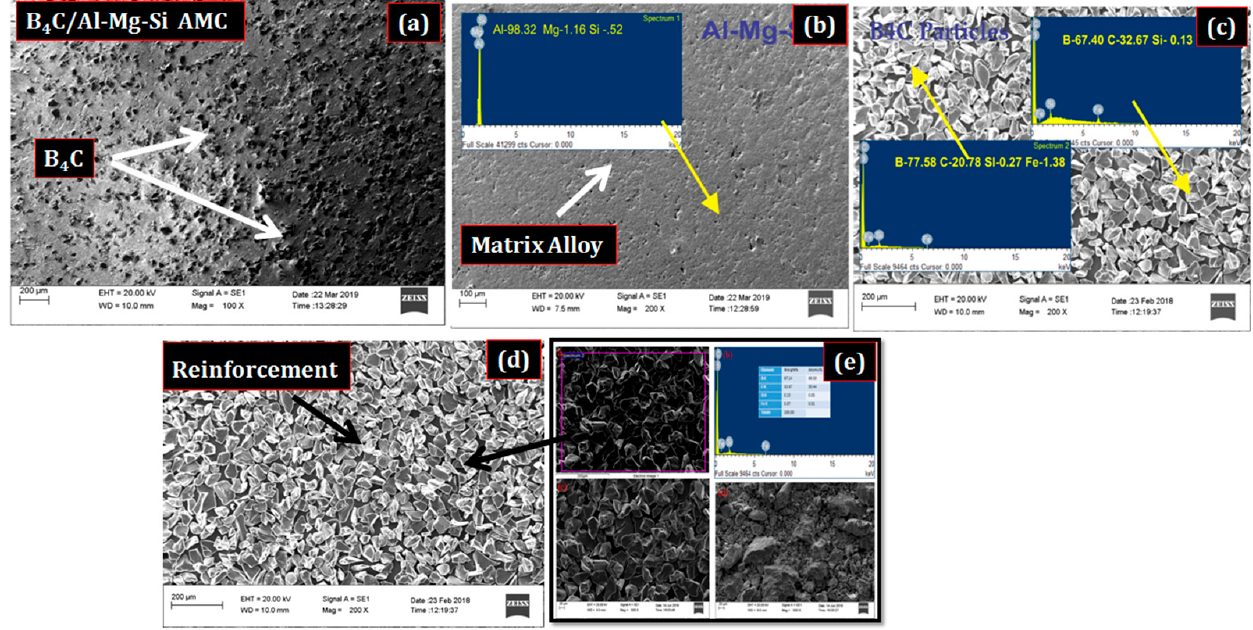
Figure 2. SEM images showing the composite morphologies. ( a ) 17.5% B 4 C/Al-Mg-Si Figure 2 . SEM images showing the composite morphologies. ( a ) 17.5% B 4 C/Al-Mg-Si AMCs ( b ) Al- Mg-Si matrix alloy, ( c , d ) B 4 C reinforcements, and ( e ) EDS of ( d ).